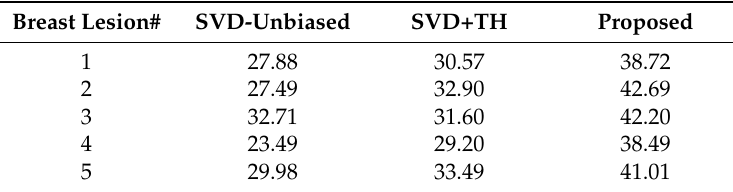
Table 3. CNR values in dB obtained by applying three different filtering methods on microvasculature images of five breast lesions.